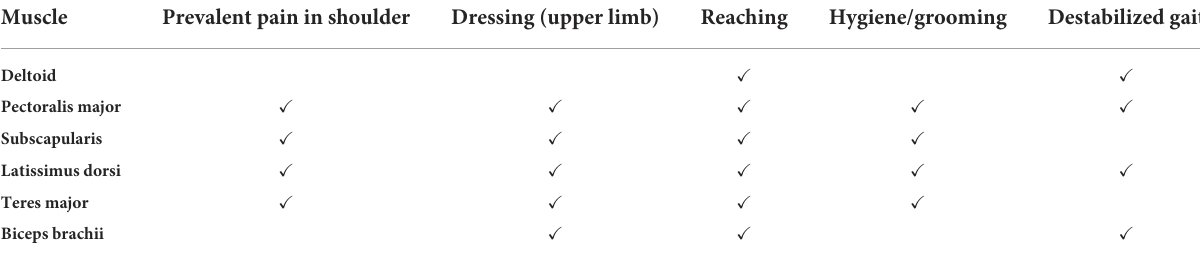
TABLE 2 Relationship of shoulder muscles with impaired activities/symptoms for identifying candidate shoulder muscles for BoNT-A injection. Muscle Prevalent pain in shoulder Dressing (upper limb) Reaching Hygiene/grooming Destabilized gait Deltoid X X Pectoralis major X X X X X Subscapularis X X X X X X X X X X X